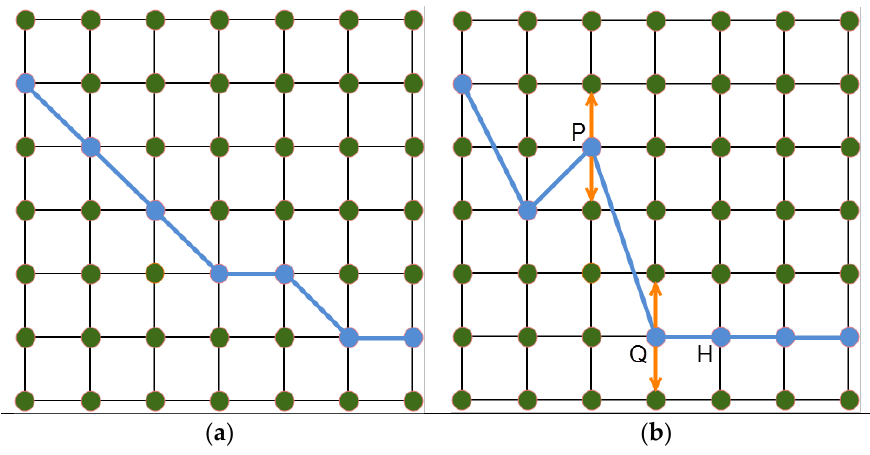
Figure 20. The relationship between waypoint and node for different algorithms. ( a ) MACO, ACO, RAS, A*; ( b ) PSO, EA.